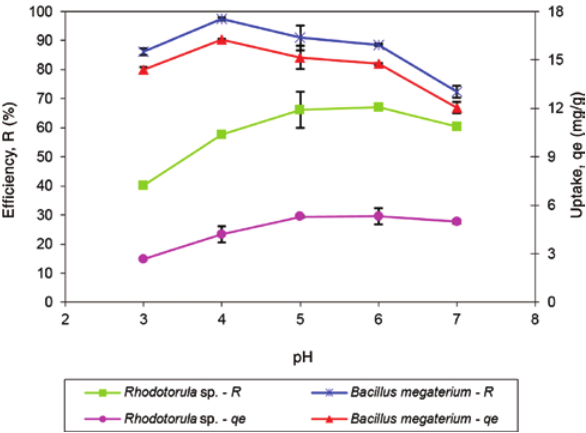
Figure 1: Influence of pH on biosorption of Cd(II) ions by Rhodoto- rula sp. (biomass dosage 5 g/l, temperature 25 ° C, contact time 48 h, initial Cd(II) concentration 50 mg/l) and B. megaterium (biomass dosage 3 g/l, temperature 25 ° C, contact time 48 h, initial Cd(II) concentration 50